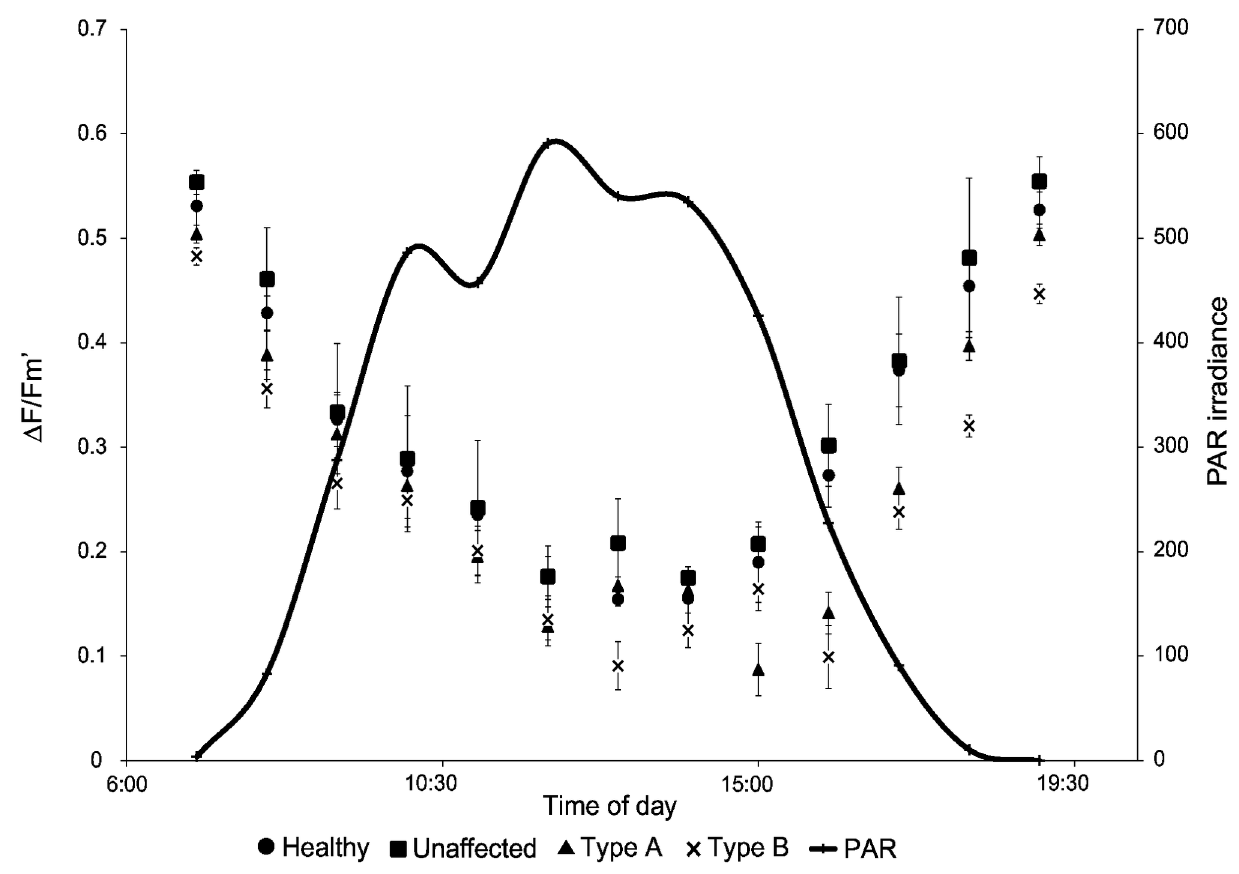
Figure 3. Diurnal tracking of photophysiology among tissue conditions. Values of F diurnal experiment. doi: